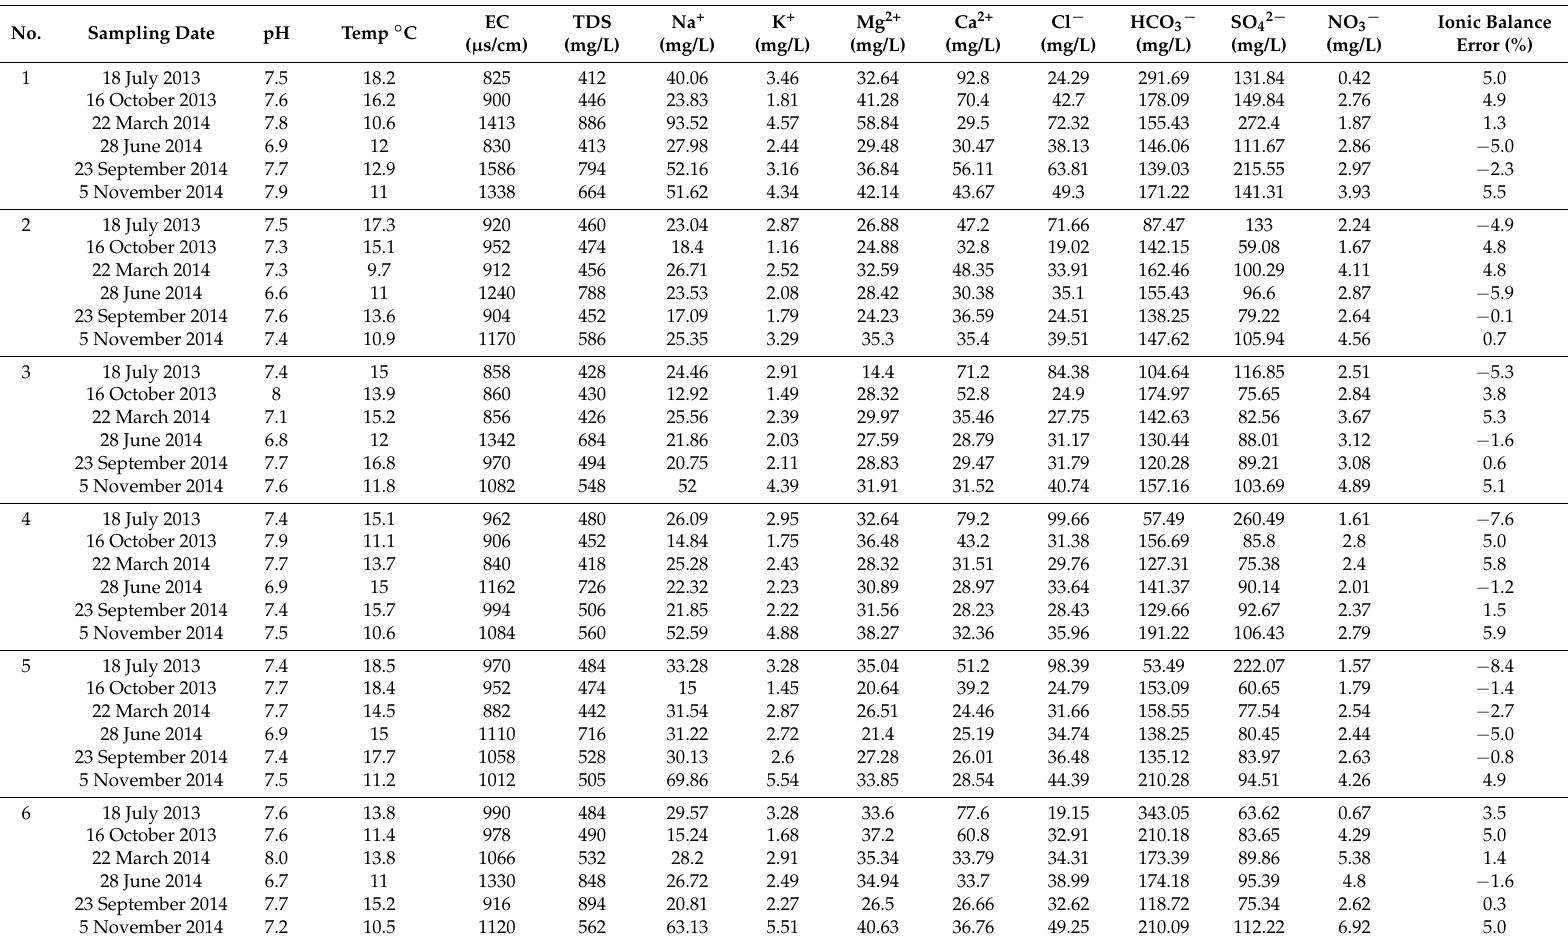
Table 2. Summary of physical and chemical data obtained for surface and groundwater samples in the study